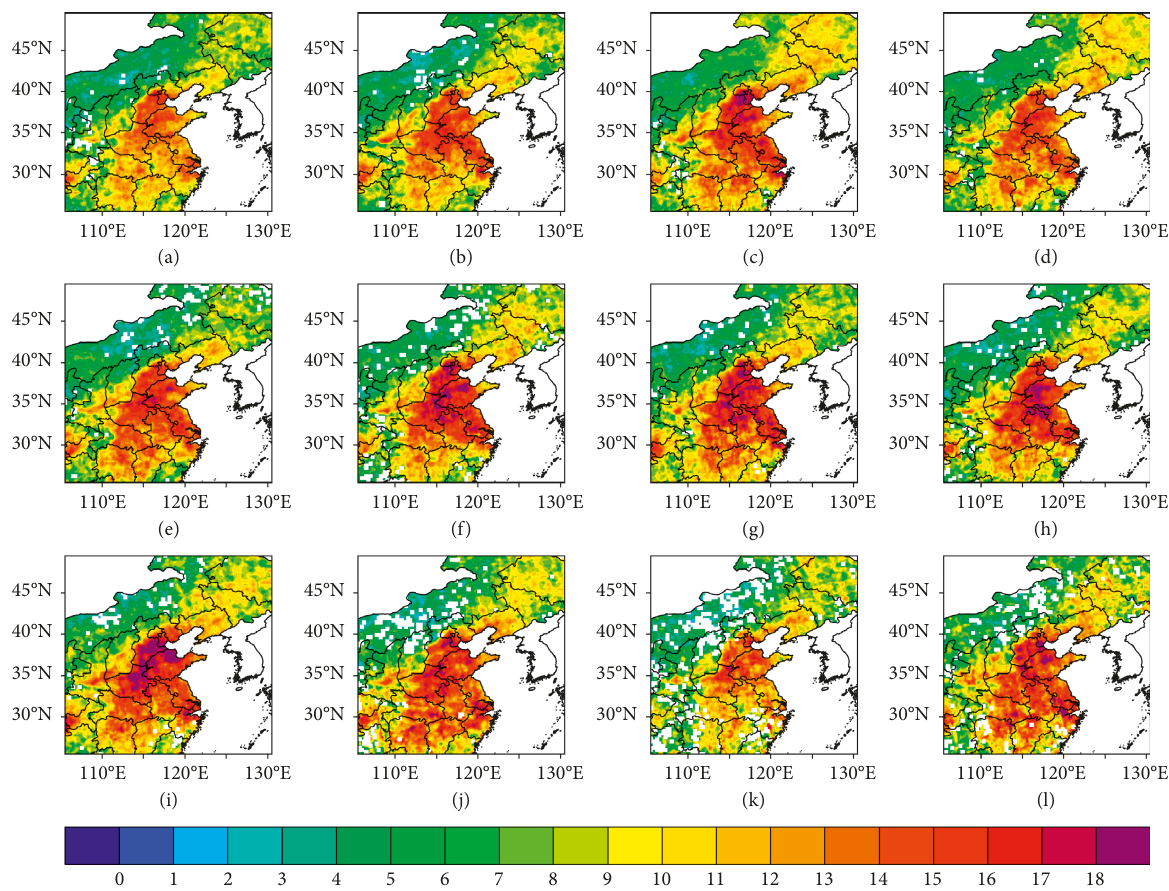
Figure 4: The spatial distribution of HCHO in summer (JJA) is from 2005 to 2016 (units: 10 18 molec